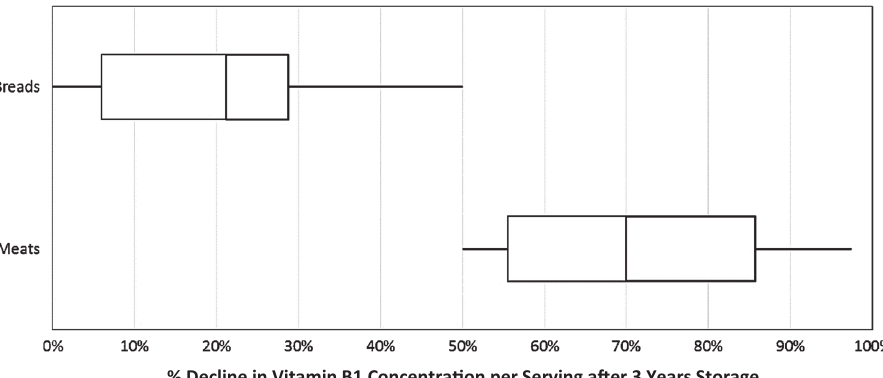
Fig. 3 Comparison of vitamin B 1 stability in breads and meats after 3 years of 21 °C storage. Vitamin B 1 concentrations in breads were sustained at higher levels than B 1 concentrations in meats. Multiple factors, including processing, food matrices, and forti fi cation may have contributed to the difference in stability over